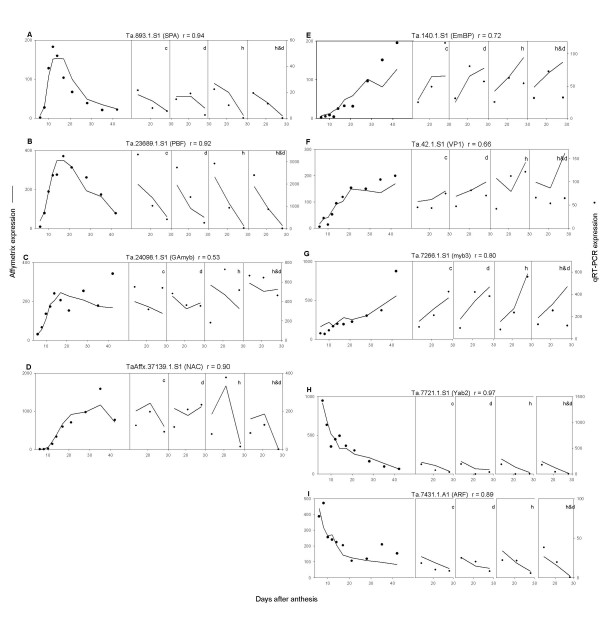
Comparison of expression estimates from wheat Affymetrix array (lines) and quantitative reverse transcription PCR (qRT-PCR; points) for nine transcription factors. The left hand panel displays data from the developmental series which are the average of two replicates. The other panels are the unreplicated controlled-environment data for control, dry, hot and hot & dry conditions. Correlation coefficients (r) between the two expression measures are indicated.